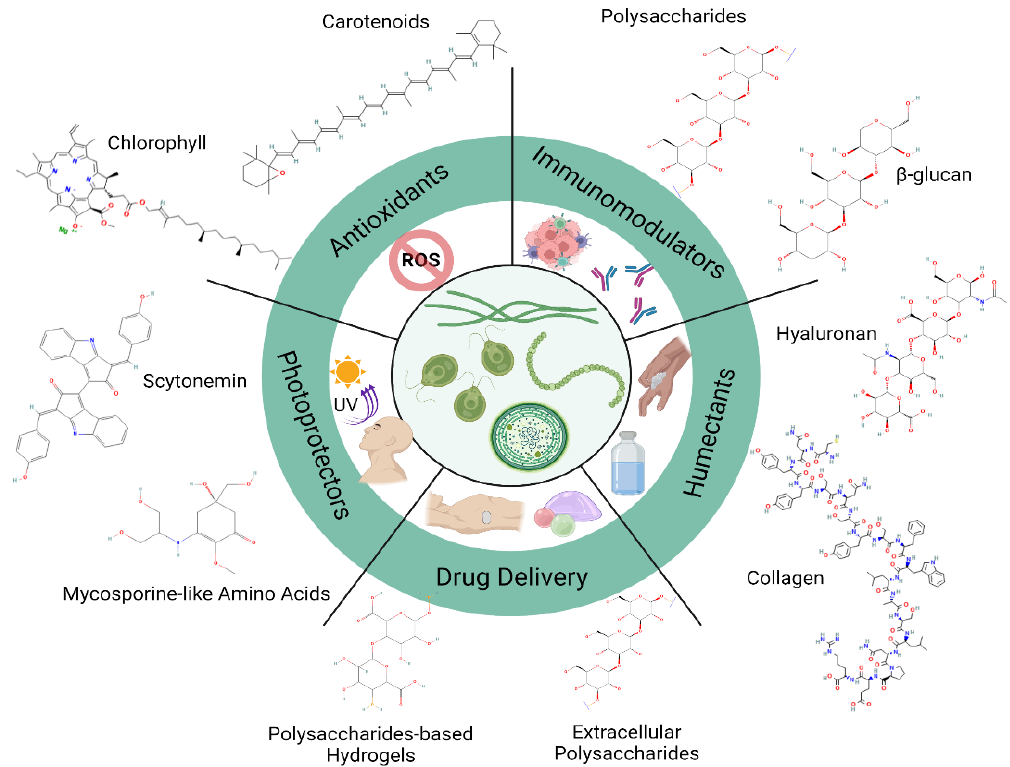
Figure 1. Molecular structure from microalgae-derived compounds used for multiple biotechnological applications.